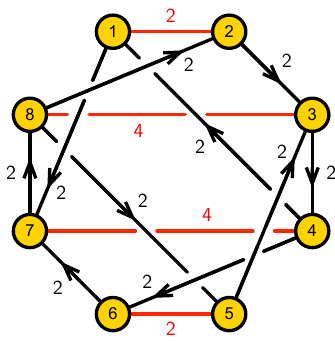
Figure 10 . Quiver for Y 2 , 2 ( CP 1 × CP 1 )